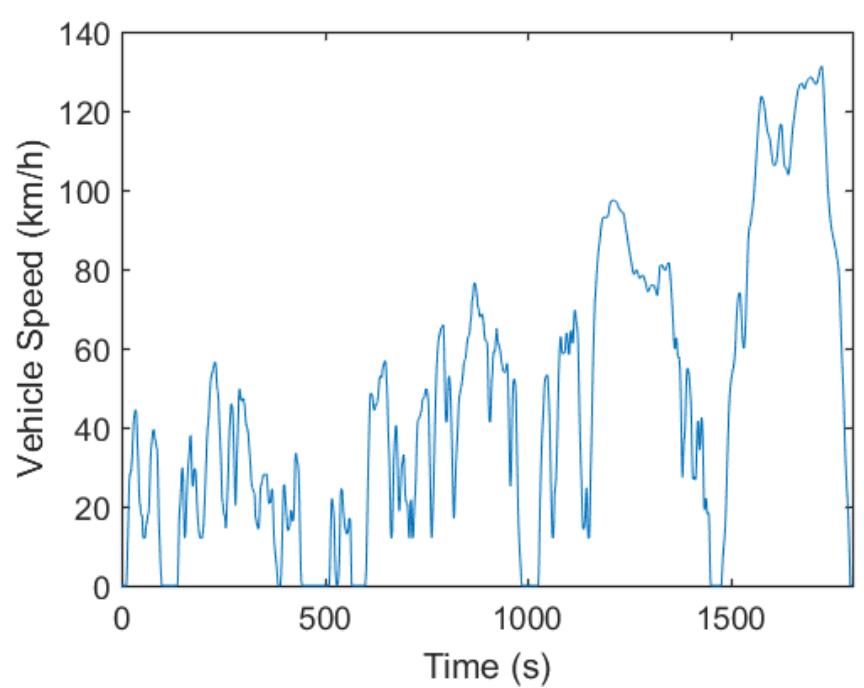
Figure 1. New European Driving Cycle (NEDC).